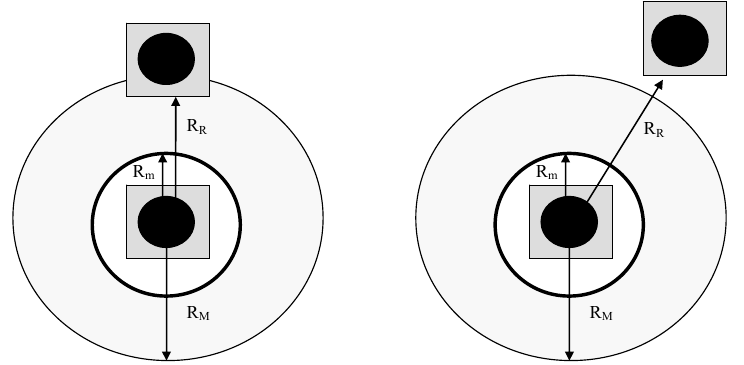
Figure 6. The assumed distance for the speed